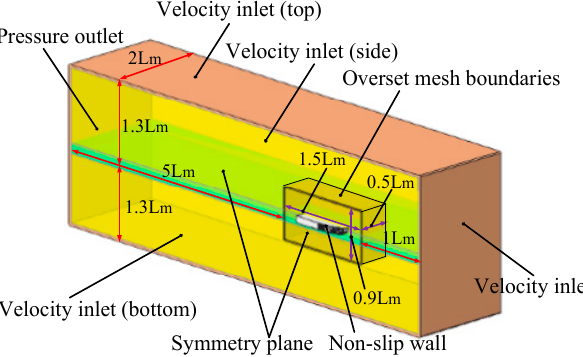
Figure 7. Dimensions and boundary conditions in the domain.